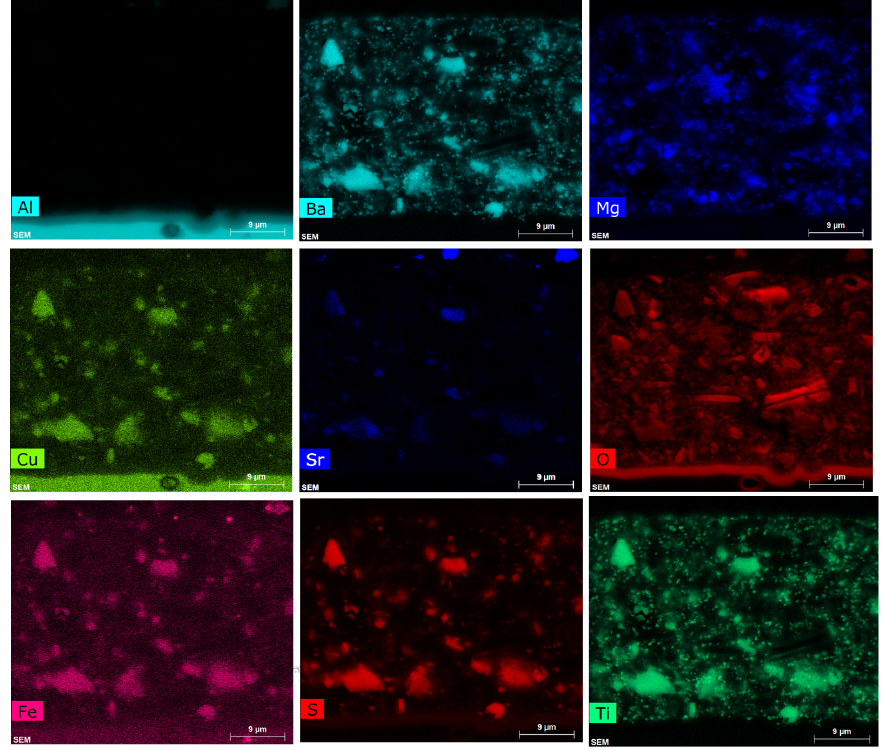
Figure A2. Elemental maps collected from the section of the primer prior to exposure to NSS.